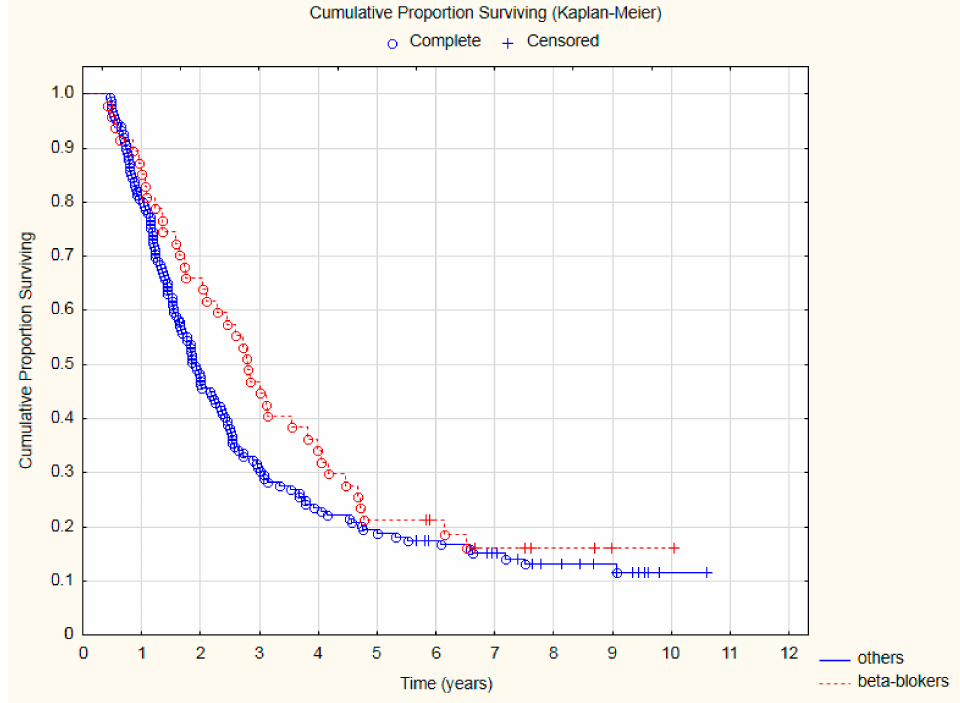
Figure 2. The comparison of overall survival in patients treated with beta-blockers due to CVD and other patients after